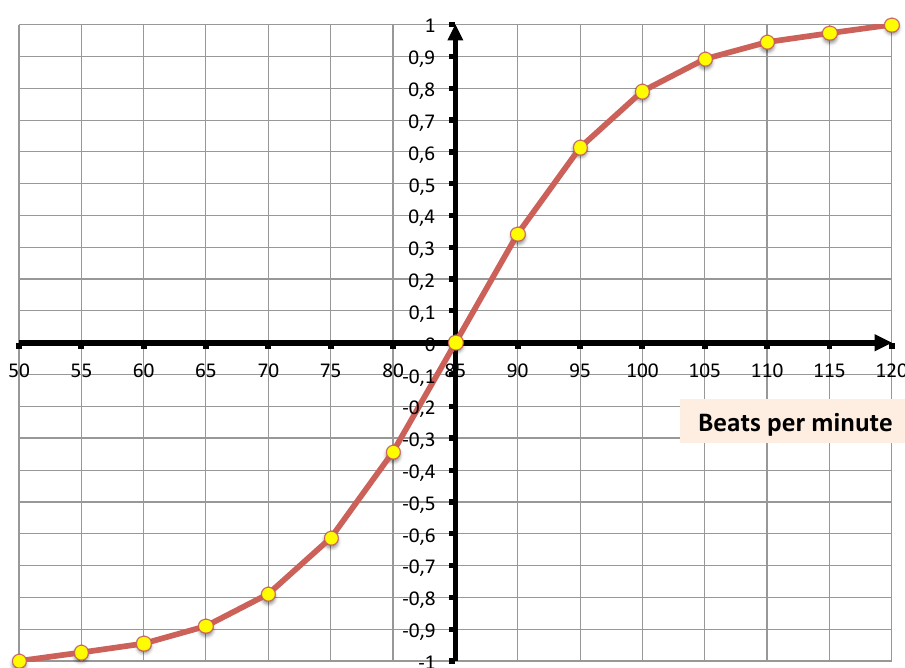
Figure 22. Fuzzy characteristic function µ CardiacFreq ( H ( x , t ) risk of PE. - Low blood pressure